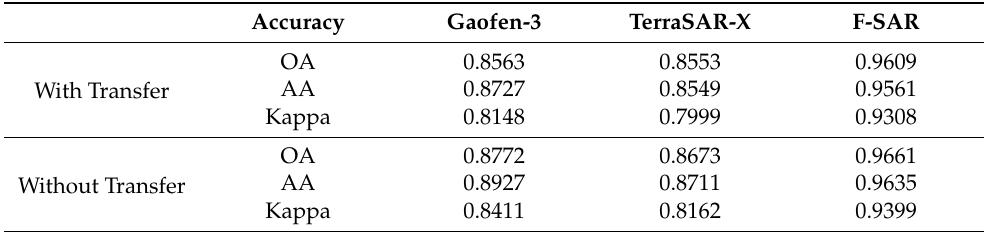
Table 11. Comparison of the performance with or without transfer model from the airborne image.